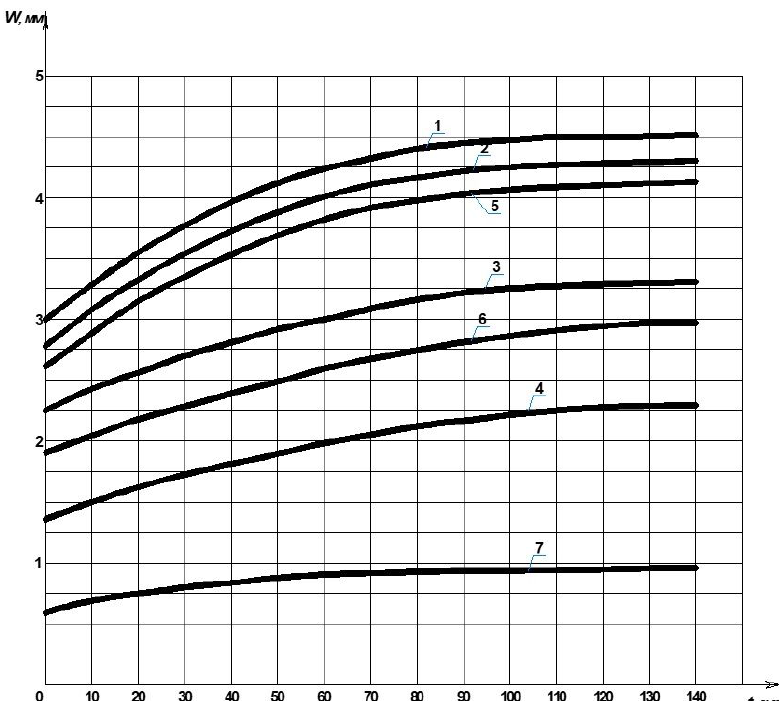
Figure 6: The growth of deflection (cm) in the calculated cross sections of the shell in time